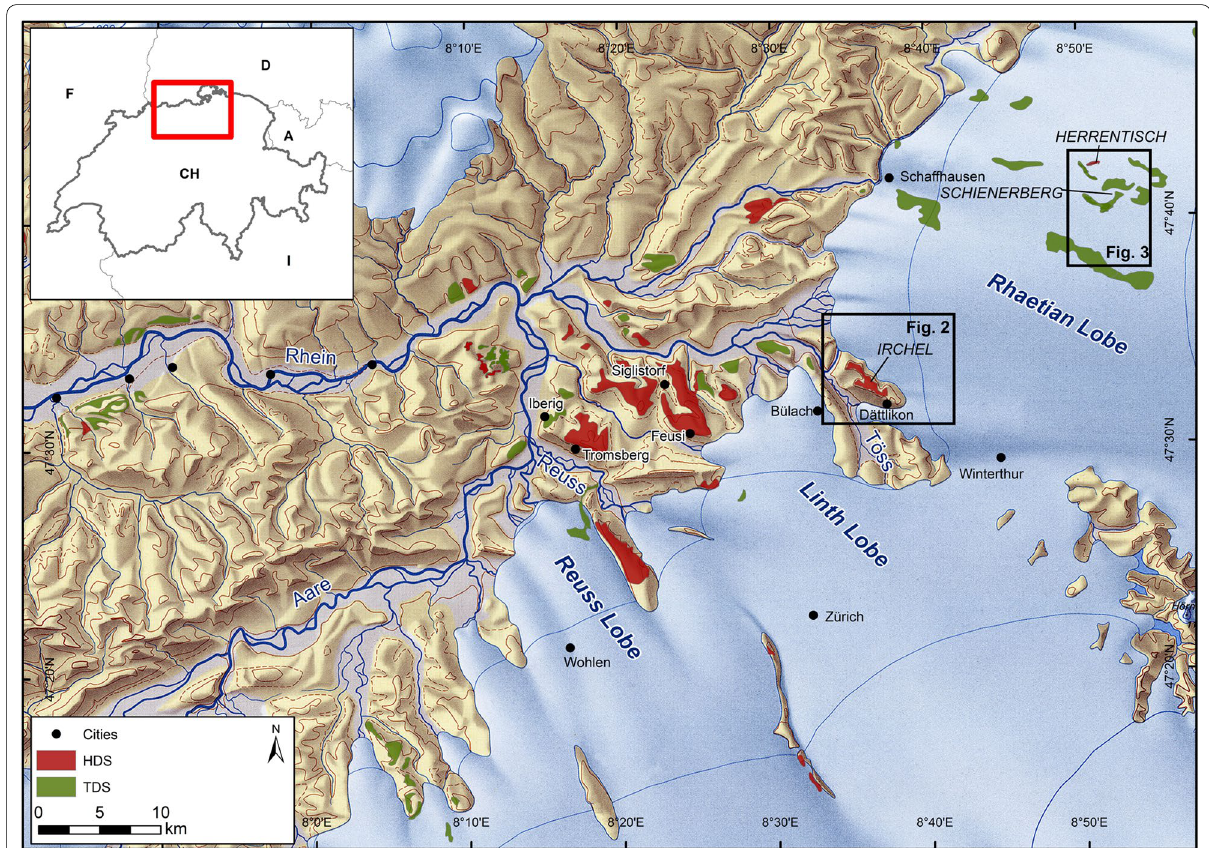
Fig. 1 The extent of the Reuss, Linth, and Rhaetian Lobes in the Swiss northern Alpine Foreland during the Last Glacial Maximum (LGM) (Bini et al., 2009) © Federal Office of Topography, swisstopo, CH-3084 Wabern. Please note that the Rhaetian Lobe is the merge of the Rhine and Thur paleoglaciers. HDS: Upper Deckenschotter Deposits; TDS: Lower Deckenschotter Deposits. The black rectangles mark the extent of Figs. 2 and